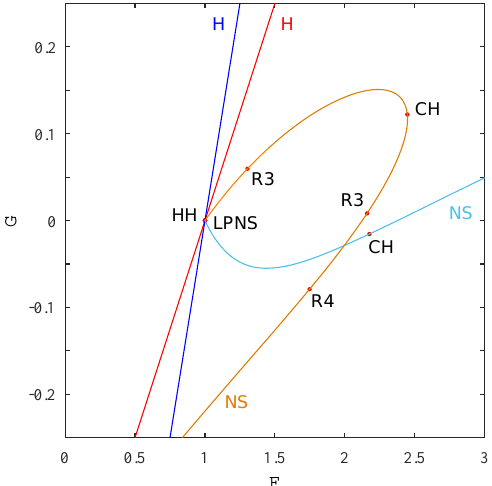
Figure 8. Bifurcation diagram of the two-parameter system (Eq. 14) in the (F,G) plane for n = 12. A double-Hopf bifurcation point is located at the point (F,G) = ( 1 , 0 ) due to the intersection of two Hopf bifurcation lines. From this codimension-2 point two Ne˘ımark-Sacker bifurcation curves emanate which bound a lobe- shaped region in which two periodic attractors